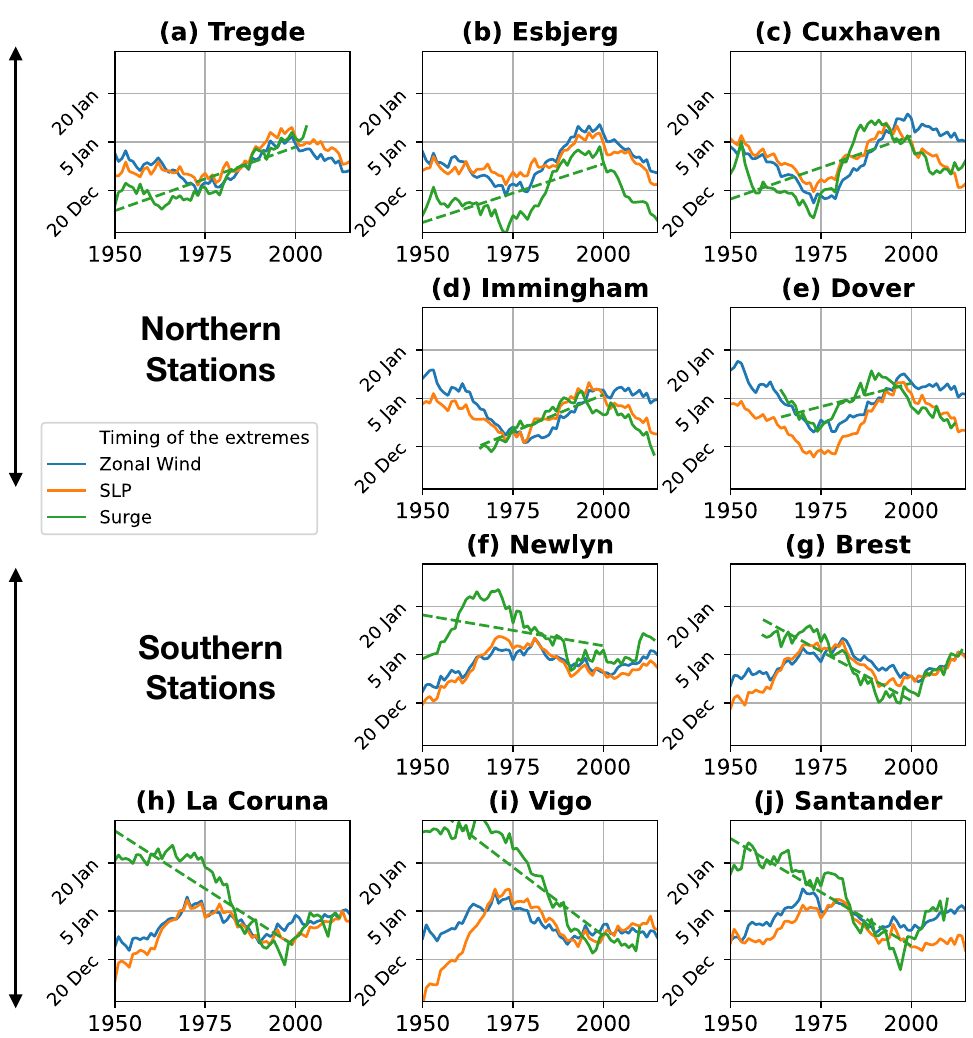
Figure 5. Timing of the extreme zonal wind (blue), extreme low pressure (orange), and storm surge season (green) for each station from 1950 to 2015. The timing is computed with the non-parametric method (method 2). Note that the meteorological data are not extracted at the point closest to the station, but at the point where the correlation with the storm surge is maximum (see text).